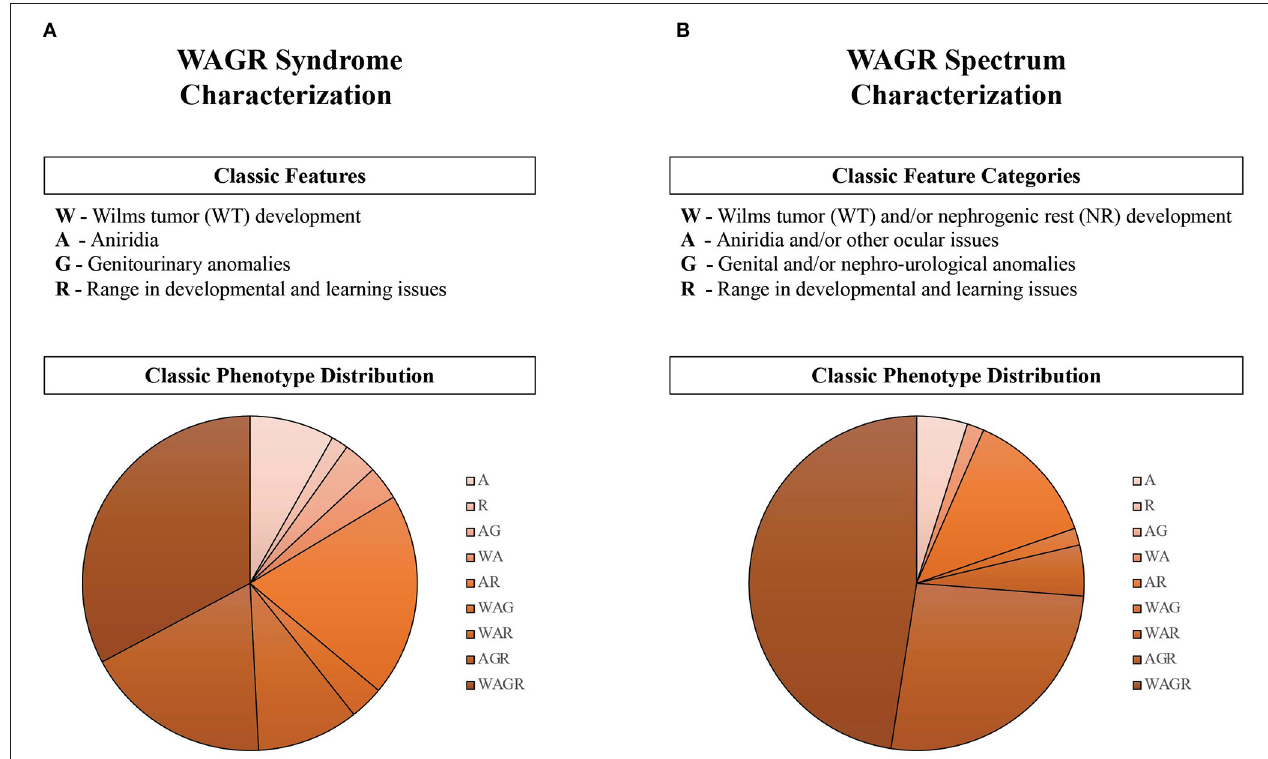
FIGURE 4 | Characterization of classic features and phenotypes in the WAGR Discovery Cohort ( n = 61). The criteria for classic features of the disorder are described for (A) WAGR Syndrome, as historically associated; and (B) WAGR Spectrum, as initially conceptualized. Phenotypes of participants are depicted in the pie charts, and describe the constellation of classic features reported by each individual (summarized by abbreviation subgroups). A spectrum of classic phenotype distributions were observed, and more phenotype subgroups were observed in WAGR Syndrome compared to WAGR Spectrum. Reclassification of “G” increased the number of participants affected by this classic feature by 18% between WAGR Syndrome (59.2%) and WAGR Spectrum (77.2%). Three main feature constellations were present in WAGR Spectrum: “WAGR,” “AGR,” and “AR” phenotypes. Close to half of participants had features consistent with the full WAGR phenotype (all four features) in the WAGR Spectrum characterization compared to approximately one third in the WAGR Syndrome characterization. Applying historical WAGR diagnostic criteria (aniridia in the presence of one or more other features) : WAGR Syndrome criteria was met in 90% of participants ( n = 55), while WAGR Spectrum criteria was met in 95% of participants ( n =